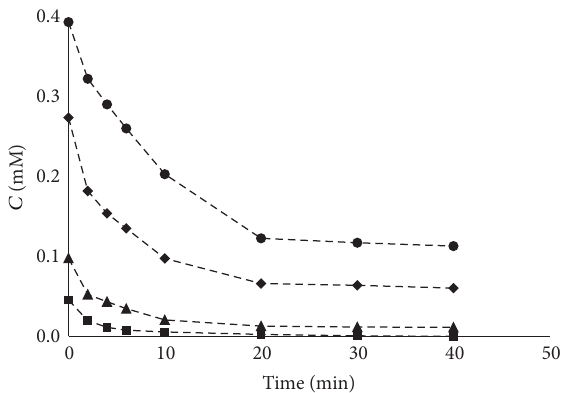
Figure 5: AG50 dye degradation varying the initial concentration of the dye by the Fenton process using 37.4 mg/g Fe 2 O 3 catalyst in tandem with UV light and ultrasonic irradiation using H 2 O 2 in stoichiometric amounts. ( e ) 0.39 mmol L −1 , ( X ) 0.27 mmolL −1 , ( 󳵳 ) 9.8 × 10 −2 mmolL −1 , and ( ◼ ) 4.6 × 10 −2 mmol L −1 .